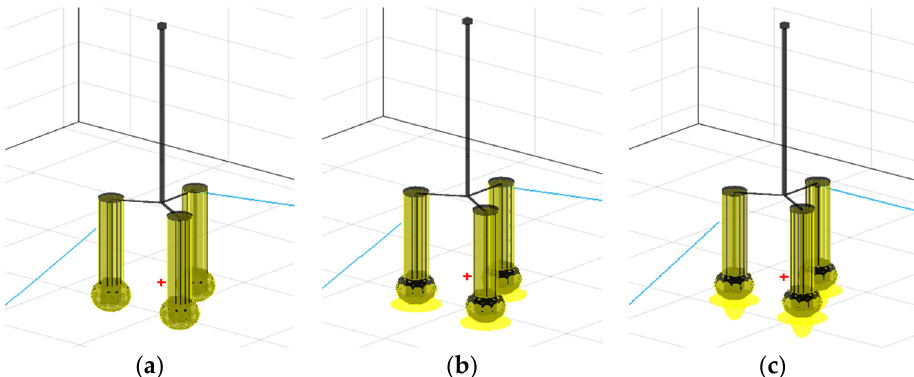
Figure 8. View of the WAMIT code models with high-order meshes and mooring setup in EDTools ® : ( a ) Sphere, ( b ) Plate, and ( c ) Semi-Spheroid models.